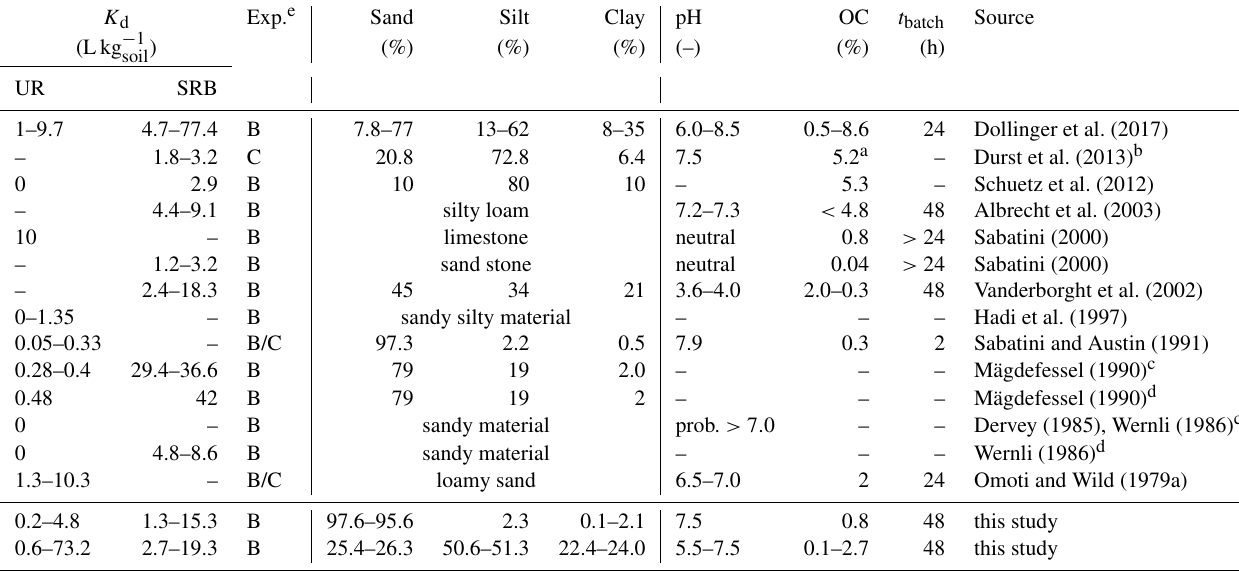
Table 1. K d values for UR and SRB found by several researchers. K d Exp.